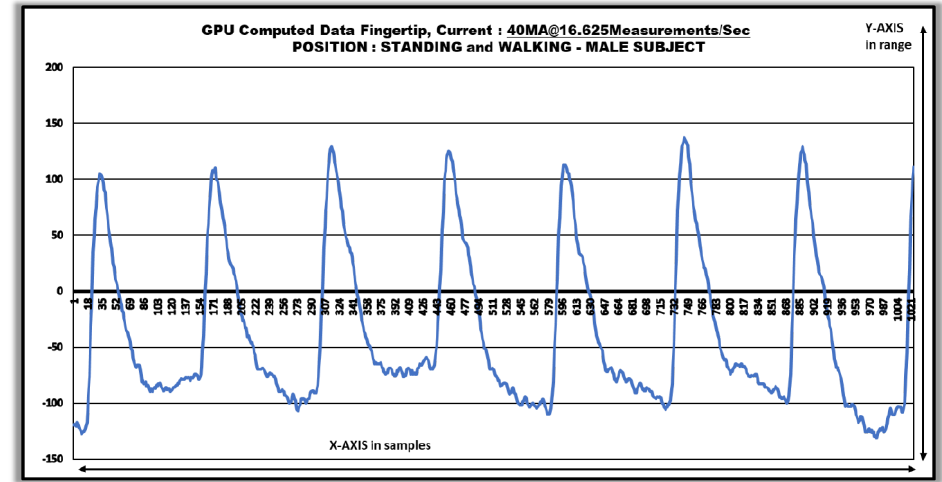
Figure 11. GPU-Computed Data using Fingertip: Observation Set C.